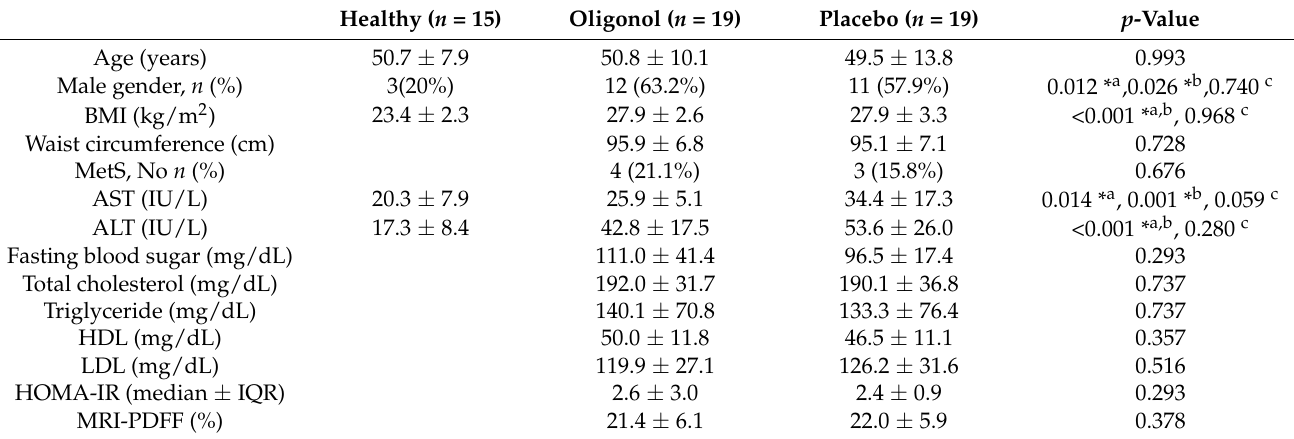
Table 1. Baseline characteristics of all participants in this study.